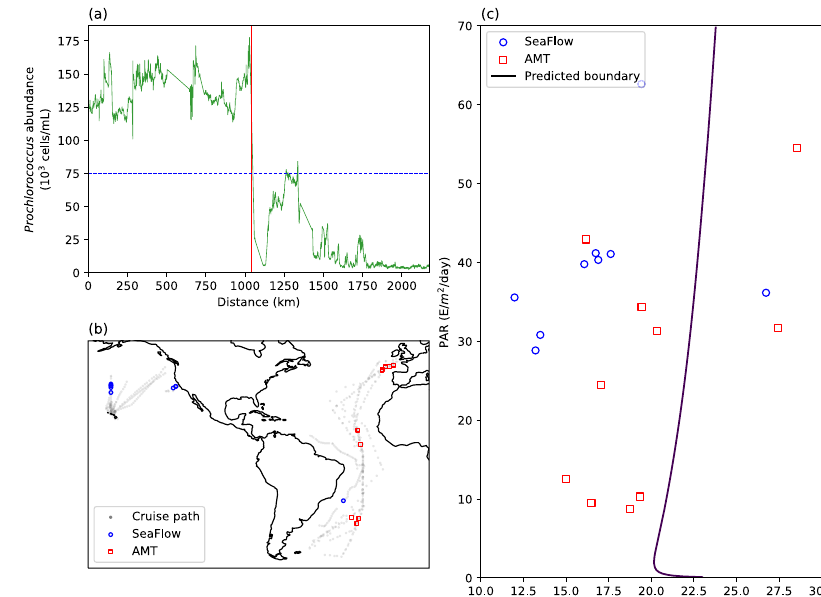
Fig. 4 | Boundary locations do not follow a contour of light and temperature. Strongshiftsin Prochlorococcus concentrationalongsurfacetransects(suchasthe one shown in a ) representing niche transitions are plotted on the map ( b ) and in